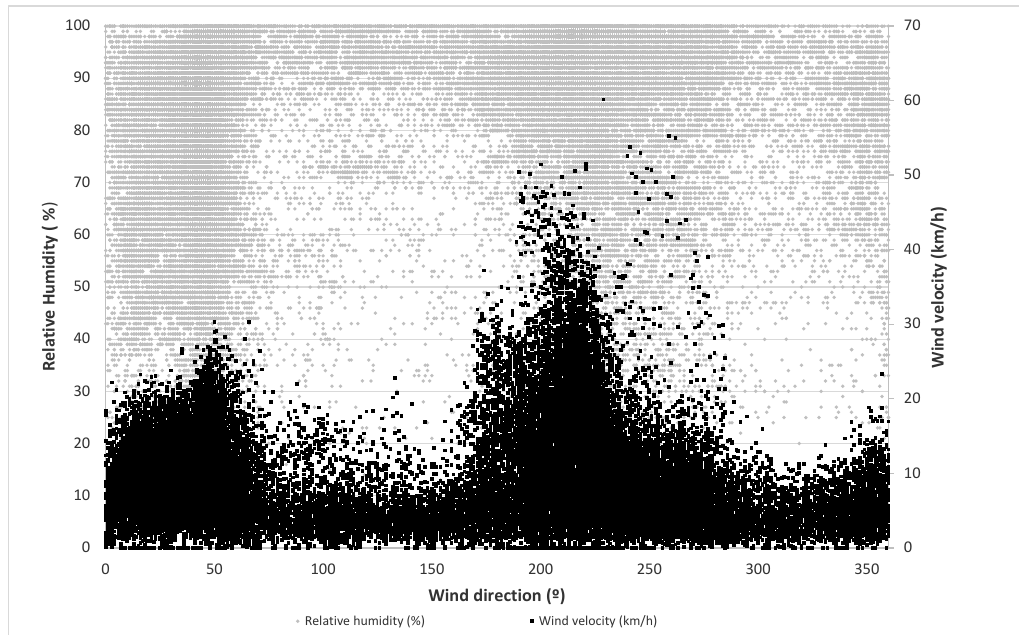
Figure 2. Relative humidity and air velocity for each wind direction.